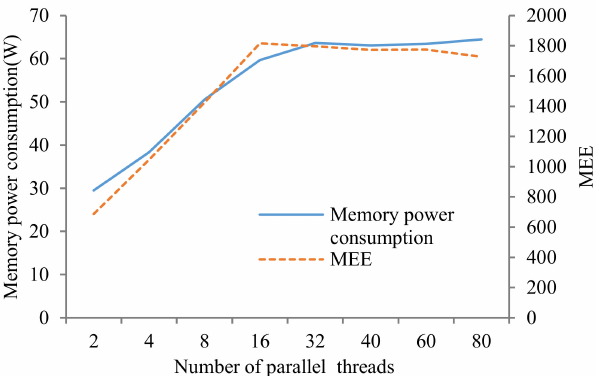
Figure 18. Experiment of multi-thread STEAM array size of 128 G under SMP